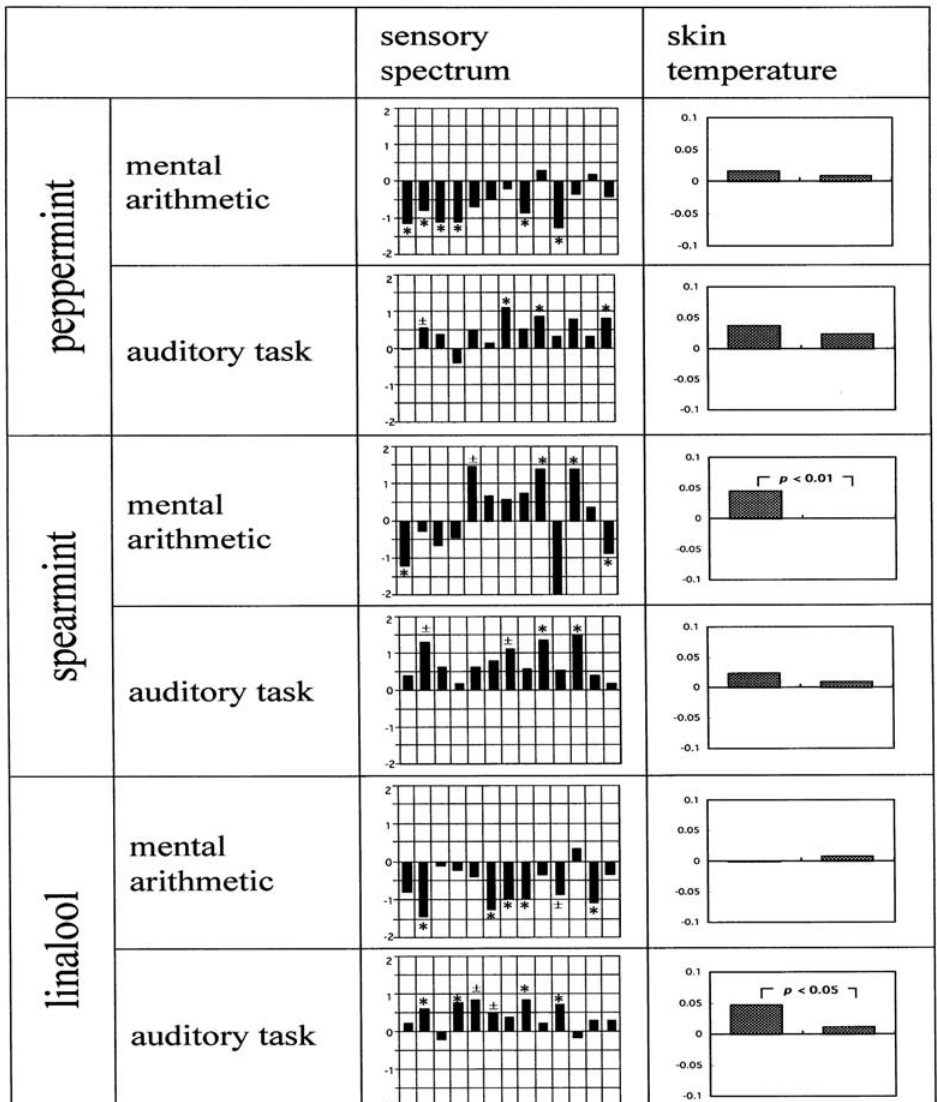
Figure 6. Summary of the verbal and non-verbal responses following inhalation of peppermint and spearmint essential oils and linalool in terms of the sensory evaluation spectrum and skin temperature changes as a function of behavioural task. Redrawn from Sugawara et al. [16]. Regarding sensory profiling study, the number of subjects was identical to that shown in Figure 1. As with skin temperature measurement study, the number of subjects was 18 for peppermint, 17 for spearmint and 20 for linalool in association with mental arithmetic; and 20 for peppermint, 18 for spearmint and 20 for linalool in relation to the auditory